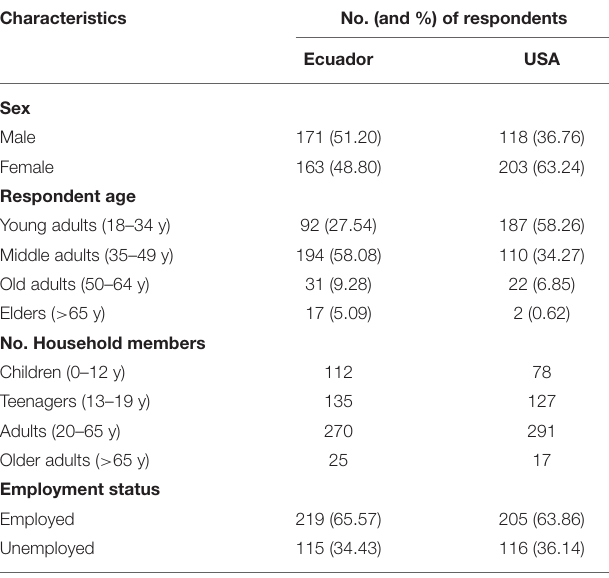
TABLE 1 | Sample demographic